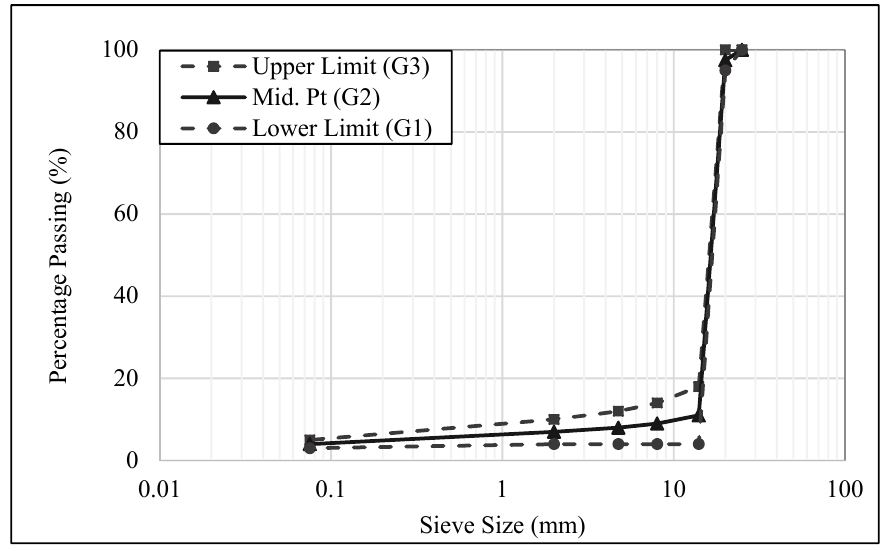
Figure 3. Aggregate gradation adopted from the Road Engineering Association Malaysia (REAM) Type-2 [56].